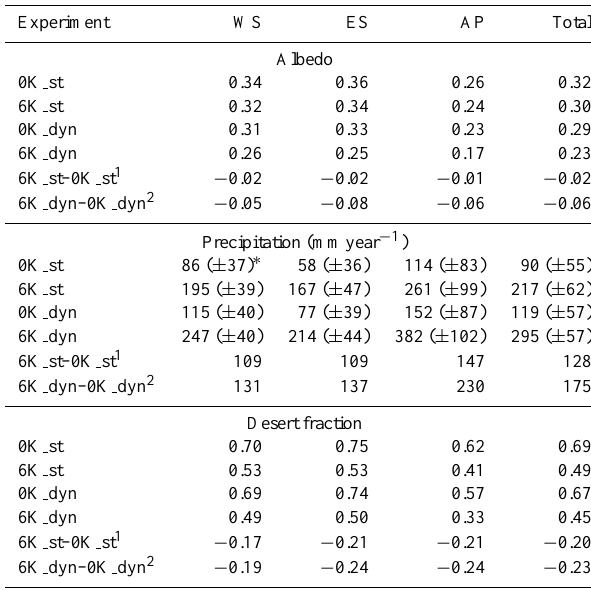
Table 3. 100-year mean albedo, precipitation (mmyear − 1 ) and desert fraction for the three areas WS, ES and AP.